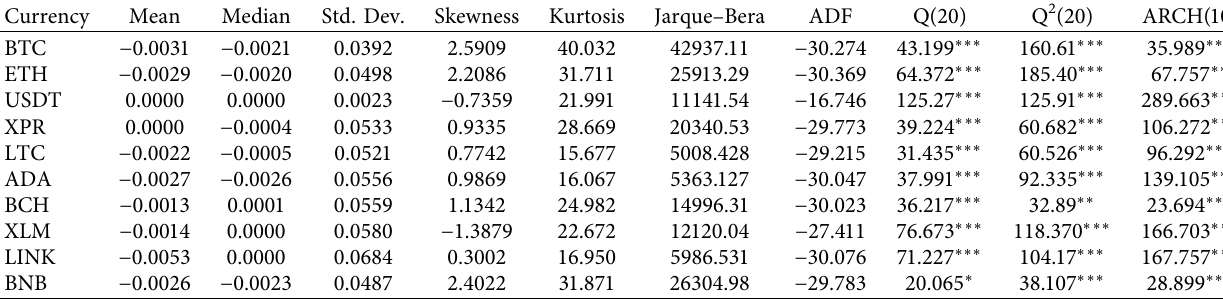
Table 2: Descriptive